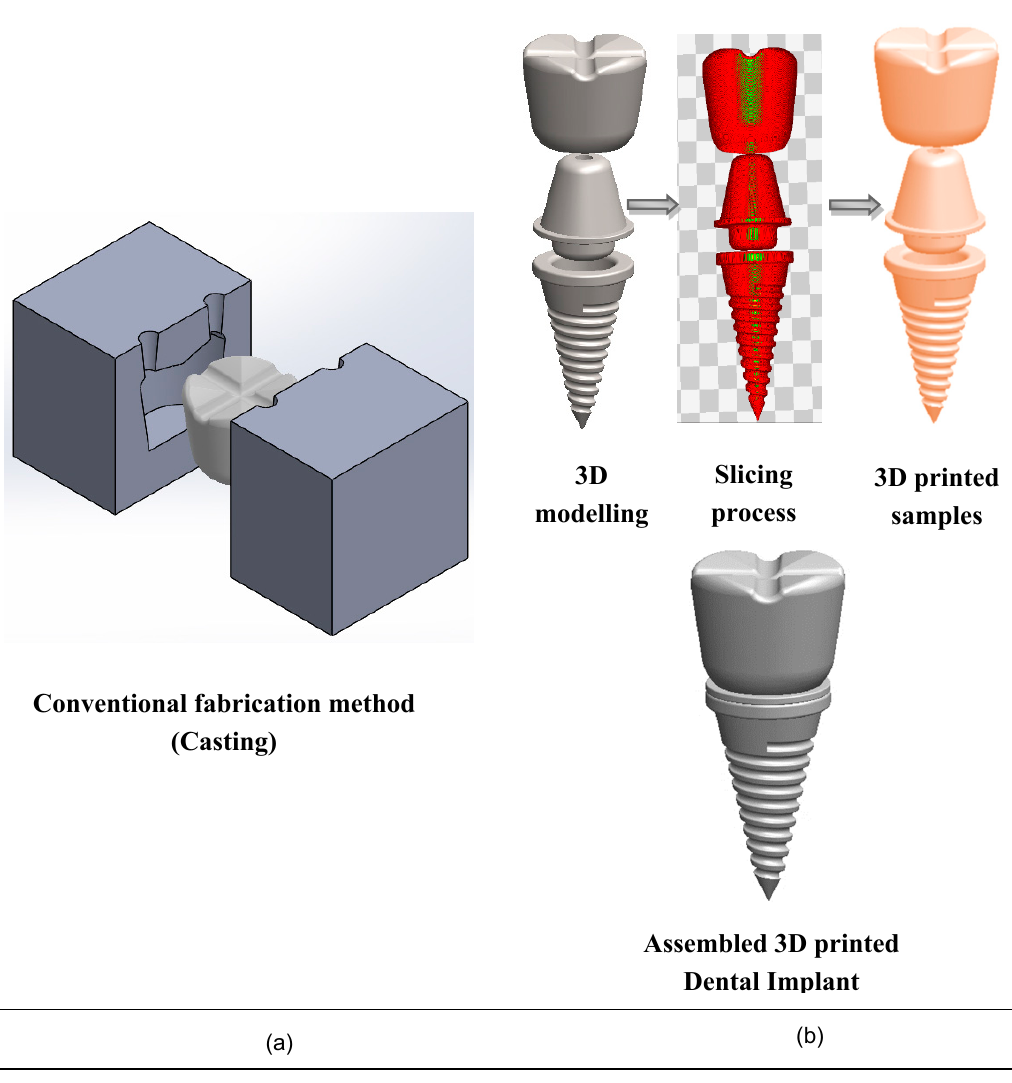
Figure 5. Fabrication techniques of dental implants. ( a ) Conventional fabrication techniques for dental implants; ( b ) 3D printing fabrication techniques for nanocomposite dental implants.